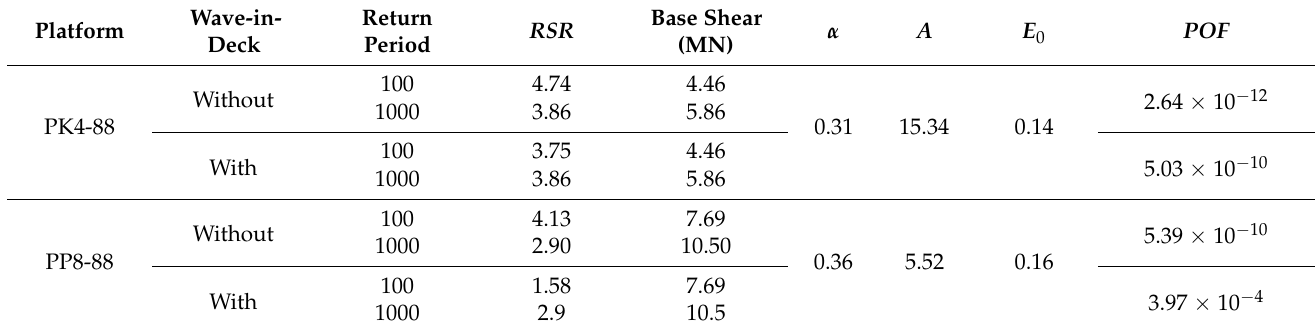
Table 4. Calculation of probability of failure.